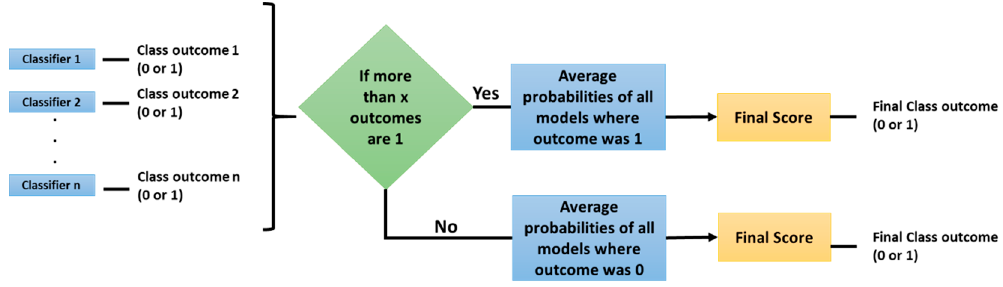
Figure 1. Selective Class Average Voting (SCAV) algorithm.